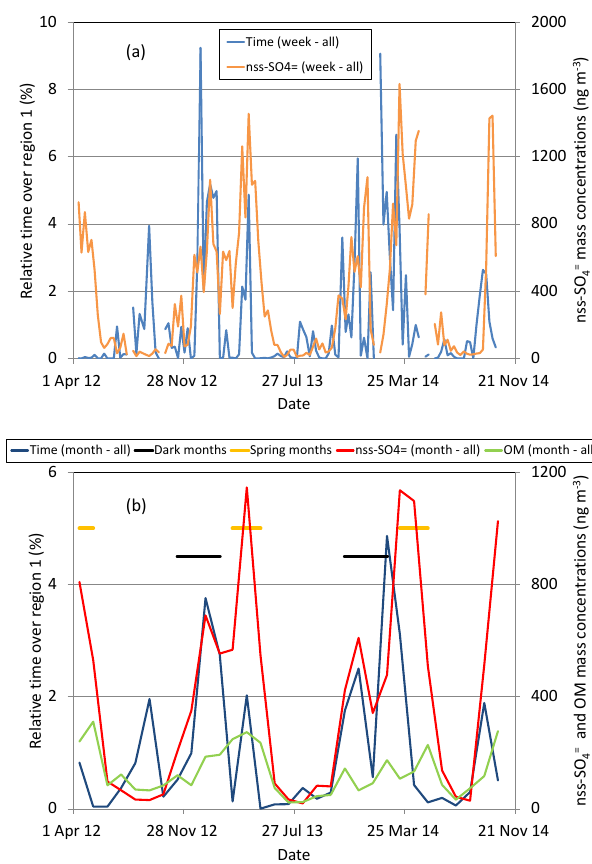
Figure 7. (a) Time series of percentage time over Region 1 from weekly averages of FLEXPART analysis with weekly-averaged nss- SO = mass concentrations. (b) Time series of time over Region 1 4 from monthly averages of FLEXPART analysis with monthly- averaged nss-SO = and OM concentrations. The bars in panel (b) 4 delineate the dark months (NDJF) and spring months (MAM).